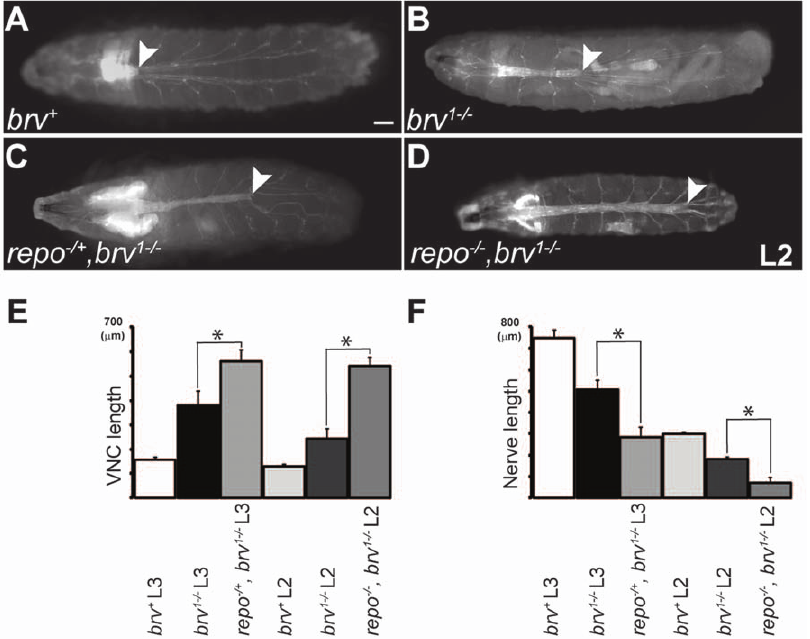
Figure 8. repo interacts genetically with GlcAT-P. Representative pictures from brv + (A), brv 1 (B), repo -/ + , brv 1-/- L3 (C) and repo -/- , brv 1-/- L2 larvae. The CNS is visualized either by Nrv2-GAL4;UAS-GFP (S65T) (A, B) or by repo-GAL4;UAS-GFP (S65T) (C–D). White arrowheads indicate the tip of the VNC. (E, F) Histograms compare the average lengths of VNCs (E) and the most posterior peripheral nerves (F) for L3 as well as L2 larvae. repo -/ + , brv 1-/- VNCs are significantly longer as compared to brv 1-/- mutants (*: p , 0.0001). Bar: 100 m m.